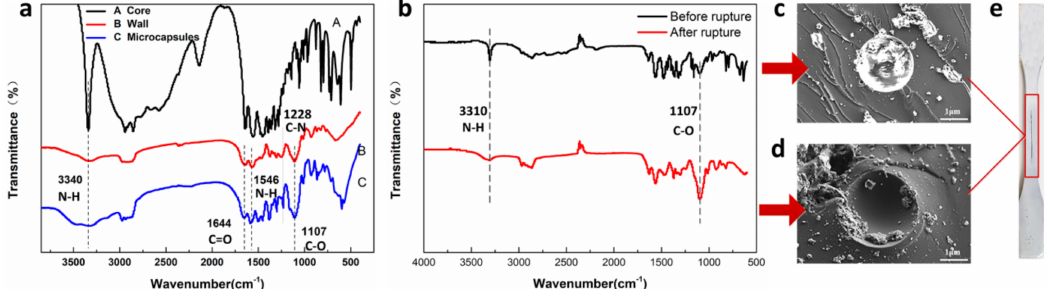
Figure 5. ( a ) FTIR spectrum of core, shell and microcapsules; ( b ) FTIR spectrum of microcapsules before and after rupture; ( c ) microcapsule before rupture; ( d ) microcapsules after rupture; ( e ) coating example with crack.3.4. Thermostability and Core Content of the